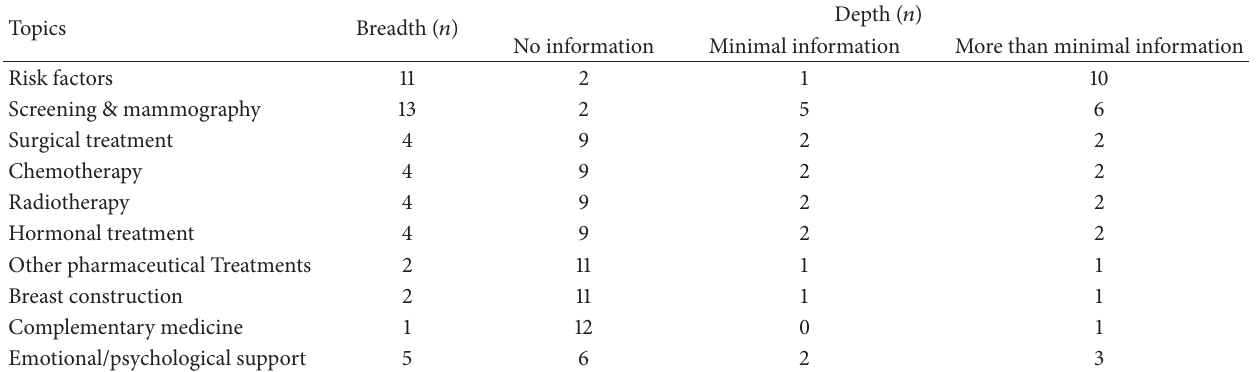
Table 2: Fulfilment of completeness